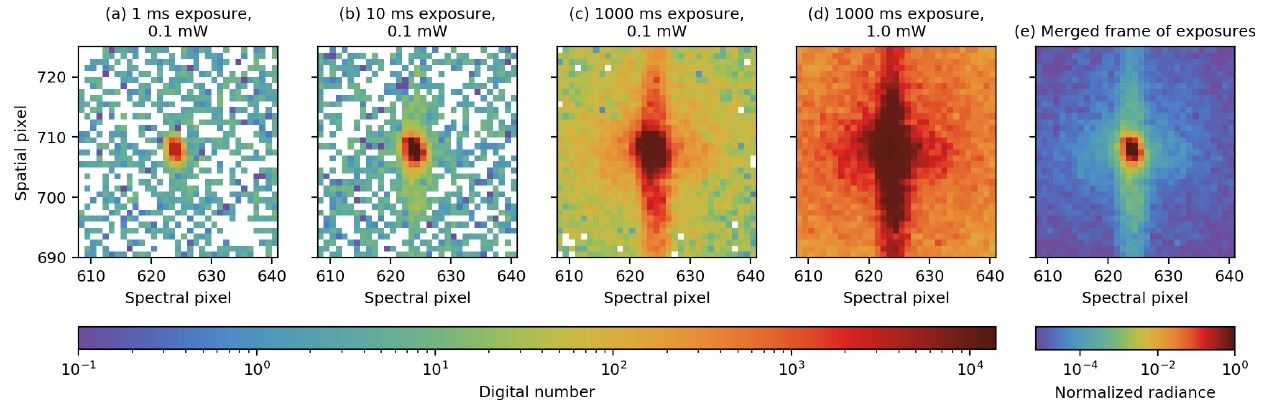
Figure 5. Individual frames with different exposure times in milliseconds and listed laser power in milliwatts (a–d) are combined to create the resulting normalized merged frame (e) . At shorter exposure times, the peak is well defined, but the floor is dominated by measurement noise. Longer exposure times allow for characterization of the floor, but the peak and its surrounding area become